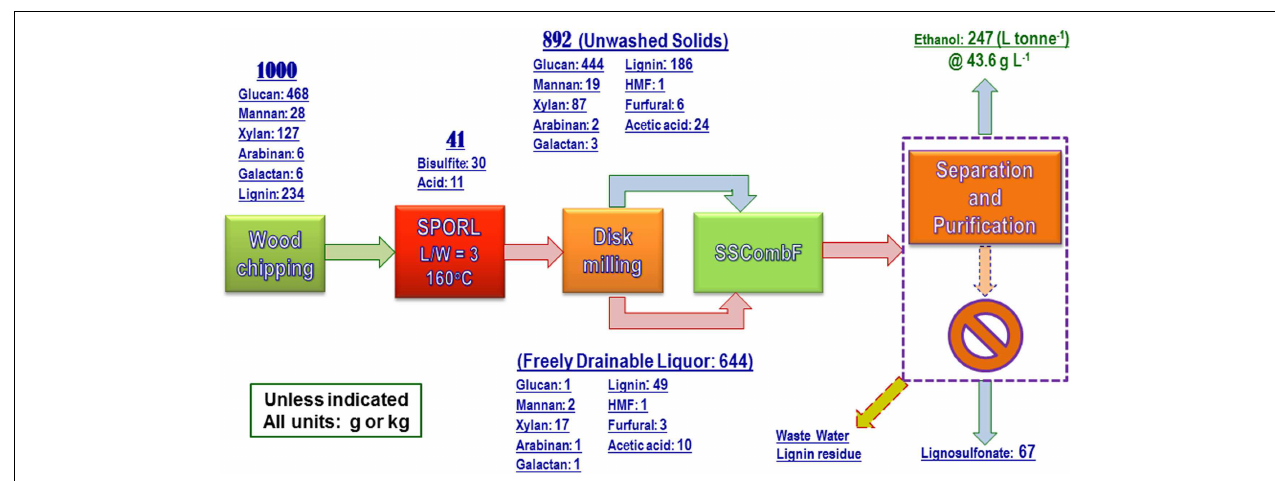
FIGURE 6 |A block diagram shows overall process mass balance for the pilot-scale pretreatment of poplar NE222 with subsequent enzymatic saccharification and fermentation . Process boxed by dashed lines was partially conducted.